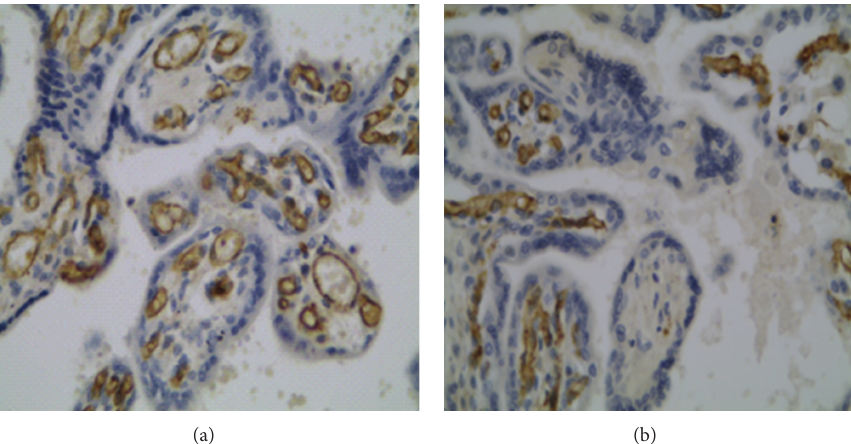
Figure 4: Immunohistochemical localization of the receptor CX3CR1 in the placental tissue at 400x magnification: (a) diabetes class C (group I); (b) normal controls (group